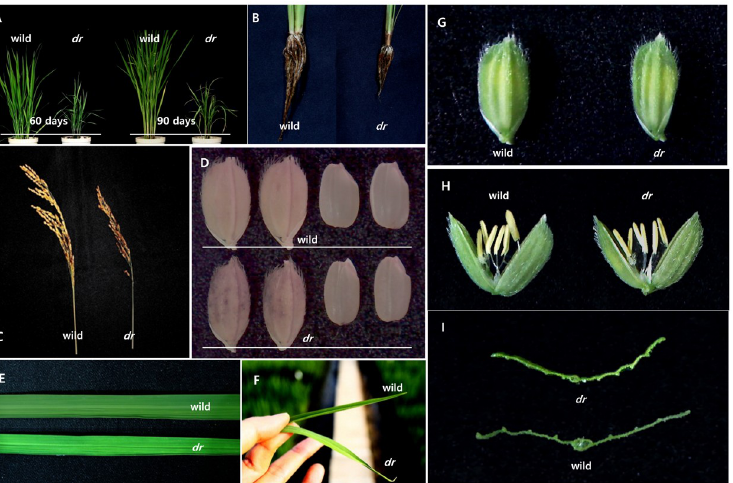
Fig 1. Comparison of the wild-type and the dr mutant phenotypes. (A) Overall shape of plants on 60-day-old (left) and 90-day-old(right). (B) The roots development in the wild-type (left) and the dr mutant (right). (C) Panicle shape of the wild-type (left) and the dr mutant (right). (D) Spikelets and seeds phenotypes of the wild-type (upper) and the dr mutant (down). (E) Morphology of 60-day-old leaves. (F) The degree of drooping leaves in the wild-type (upper) and the dr mutant (down). (G) Spikelets of wild-type (left) and the dr mutant (right) before flowering. (H) Physically opened spikelets of wild-type (left) and the dr mutant (right), before flowering. (I) Cross-section of the dr mutant (upper) and the wild-type